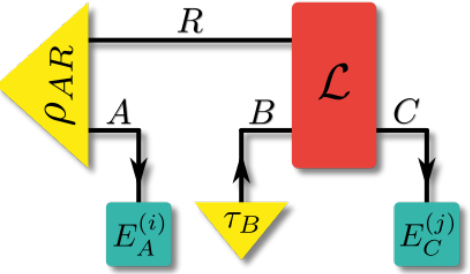
Figure 3: Building blocks of a two-step process. The structure of a two-step process depends on the respective properties of the initial system-environment state ρ ∈ B ( H ⊗ H ) , the map L : B ( H ⊗ H ) → B ( H ) , and their interplay. Identifying AR A R A R C each of the ‘legs’ of the process with a different party, Alice and Charlie can measure ( j ) ( i ) and E ), while Bob their respective inputs (with corresponding POVM elements E A C can feed states τ into the B